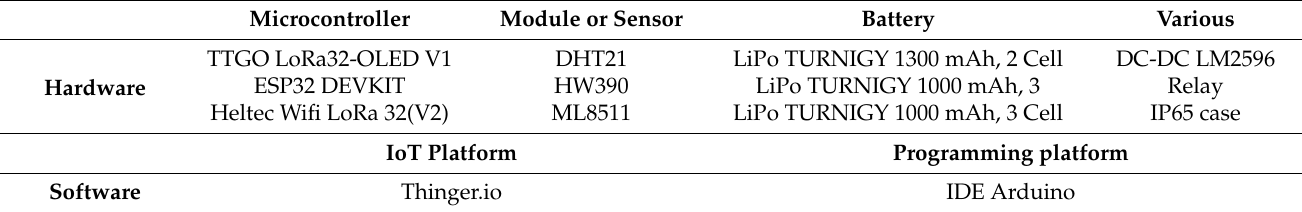
Table 1. Hardware and Software